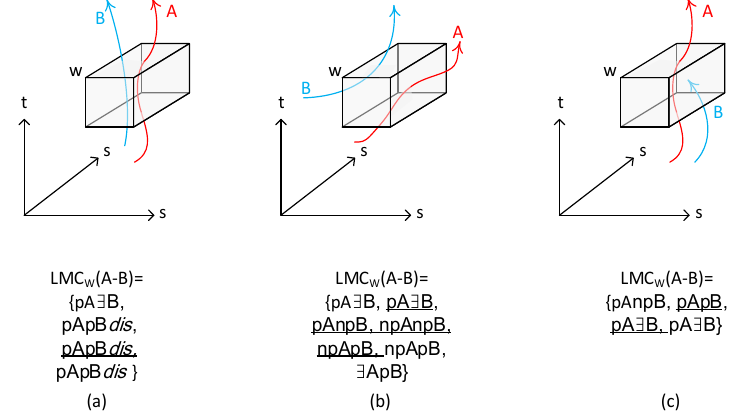
Figure 3. Three examples of the description of relations between spatio-temporal stories by means of life and motion configurations: ( a ) two objects located in the workspace before, during and after its activity; ( b ) object A leaving the workspace during its period of activity while B arrives later at the beginning of the workspace activity; and ( c ) an object B whose existence ceases during the activity of the workspace.